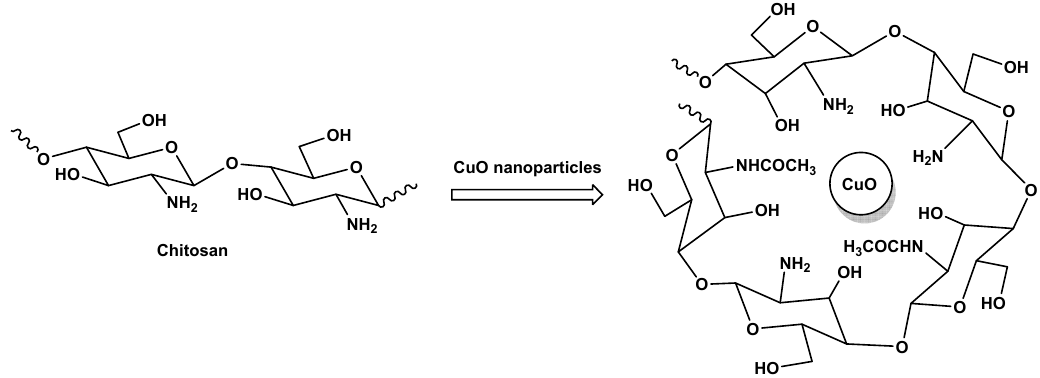
Scheme 1. Illustrative view of chitosan-CuO